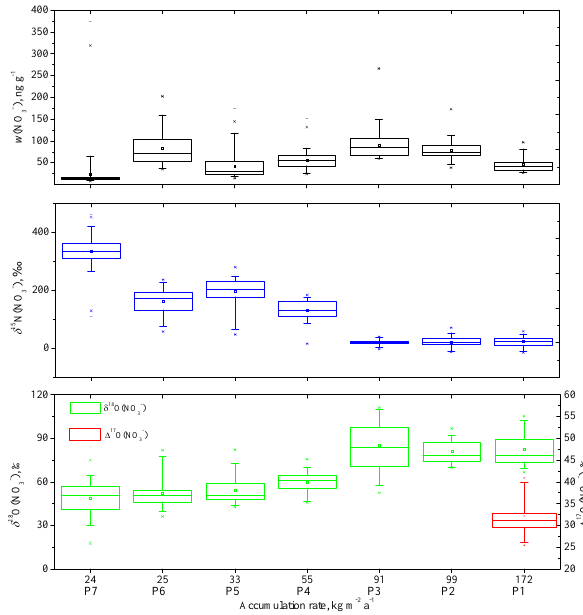
Figure 2. Statistics of mass fraction and isotopic compositions of NO − for each snowpit (P1–P7), plotted as a function of snow ac- 3 cumulation rate. Box and whisker plots represent maximum (top end dash symbol for each box), minimum (bottom end dash symbol for each box), the range 1–99% (top and bottom X symbol for each box), percentiles (5th, 25th, 75th, and 95th), and median (50th, solid line) and mean (open square near center of each box). Note that the ) are only available for P1 snowpit and refer to data of (cid:49) 17 O(NO − 3 the right-hand